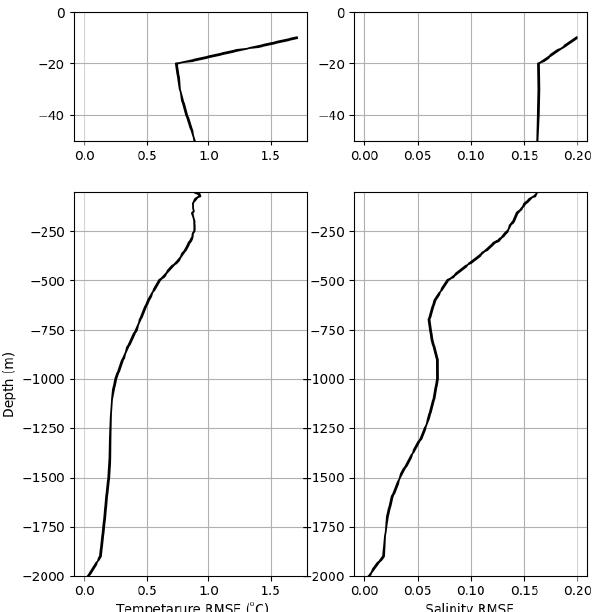
Figure 7. RMSE profiles for temperature ( ◦ C) and salinity (gkg − 1 ) of the Moana Ocean Hindcast simulation in relation to the CORA5.2 observations. A zoom-in of the first 50m where the larger differences are observed is provided in the upper